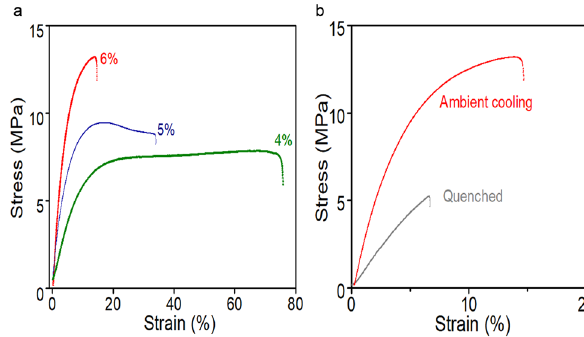
Figure 6: The stress – strain curves; ( a ) fi lms doped with di ff erent concentrations of ZnO NPs; ( b ) fi lms which were post hot - pressed by quenching or ambient temperature cooling.